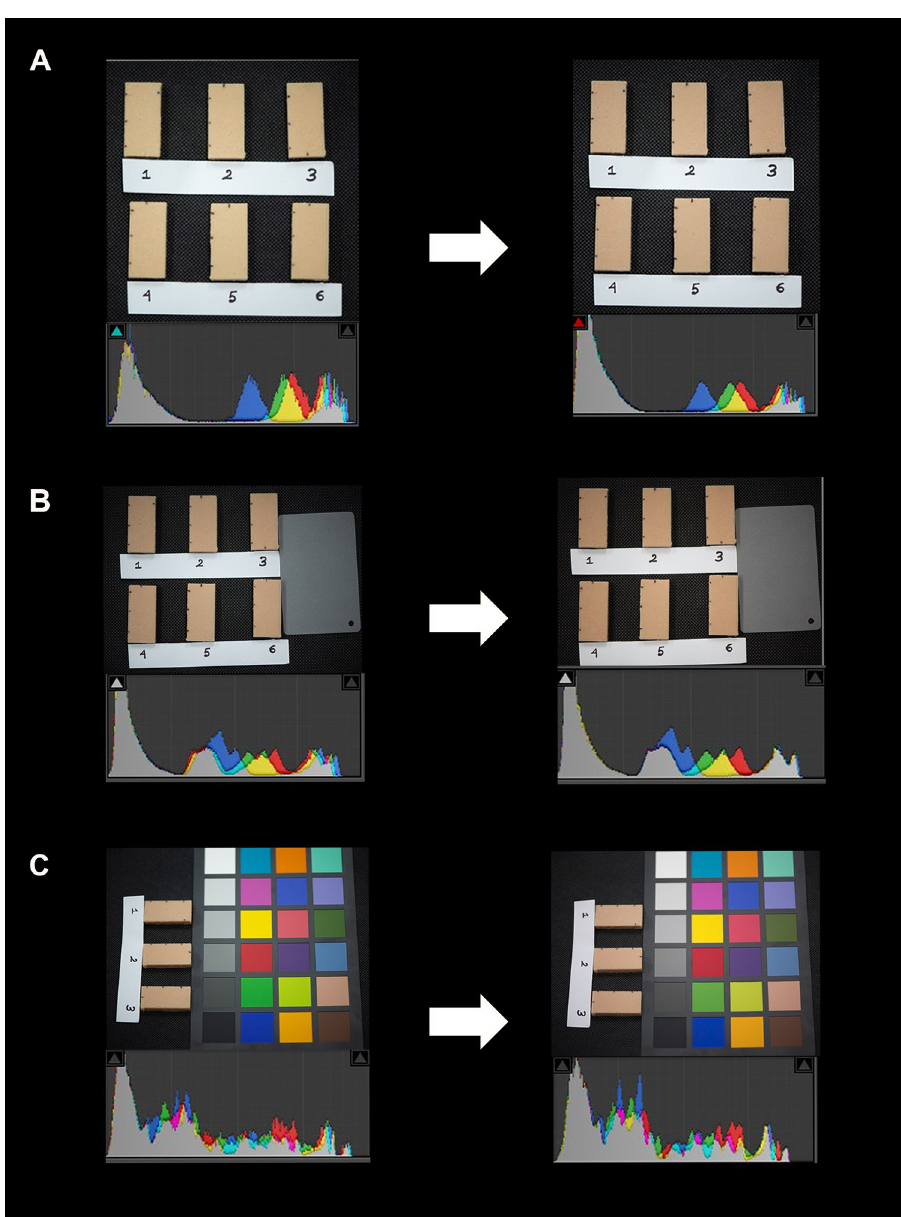
Fig 1. Before after color differences of prosthetic silicone blocks for A) camera calibration, B) PPWBC using gray card and C) PPWBC using color chart.